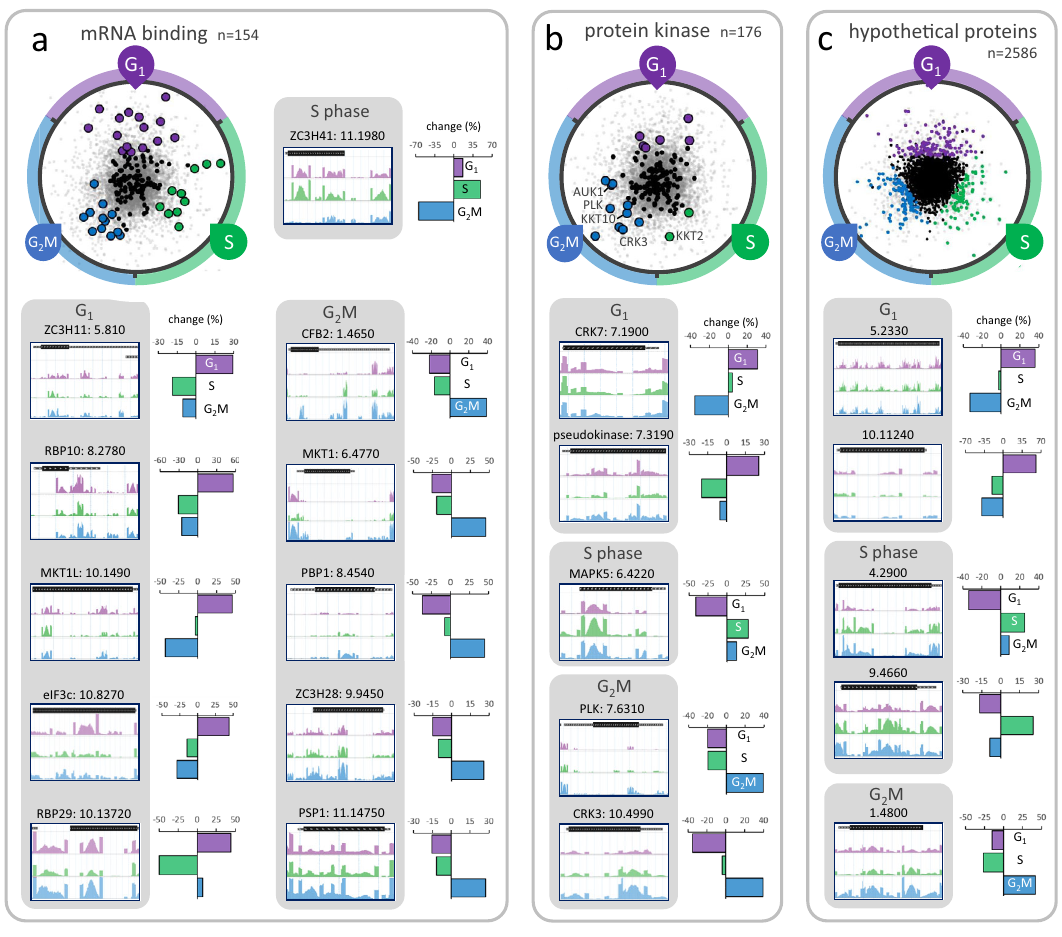
Fig. 6 | RBPs, kinases and hypothetical proteins associated with gap and S phase defects. a The RadViz plot shows mRNA binding protein knockdowns (RBPs).Those thatregistered >25% overrepresented read-counts in the G 1 , S phase or G 2 M categories are indicated, in purple, green and blue, respectively. The read-